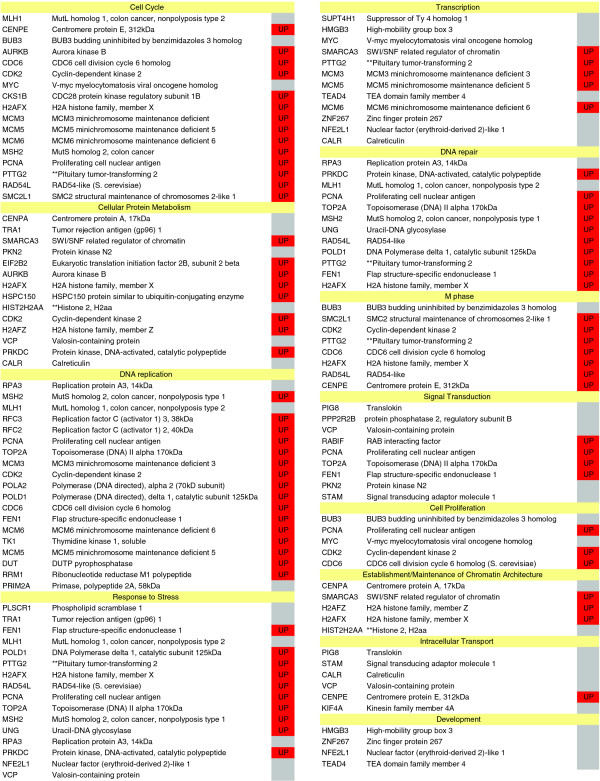
Ad5 induced changes of expression of E2F target genes organized by function. E2F target genes, identified by Ren and coworkers [86], were organized by cellular function. Genes significantly regulated by Ad5 (those that pass fold change filter applied previously) are indicated with red/UP or green/DOWN. Grey indicates genes not significantly regulated by Ad5. (Note that none of the 67 E2F target genes were significantly downregulated.)